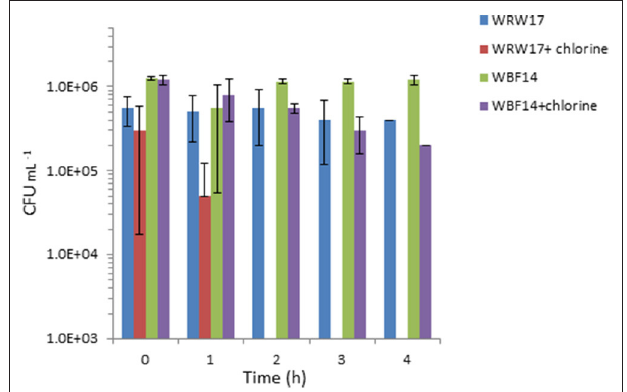
FIGURE 4 | Effect of chlorination (2mg L − 1 NaClO) of treated greywater on the survival of two strains of isolated Serratia (SYS3-RW17 and SYS3-BF14). T 0 represents the initial contact time with the chlorine. After 2h, WRW17 + chlorine counts were